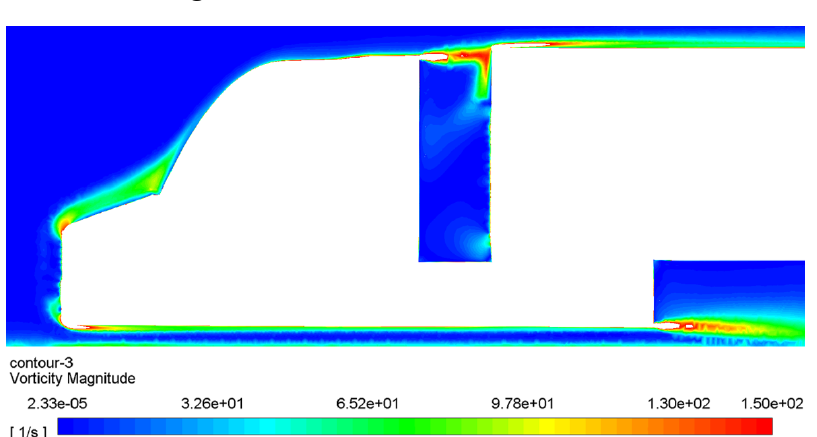
Fig. 9. Flow vorticity magnitude over the